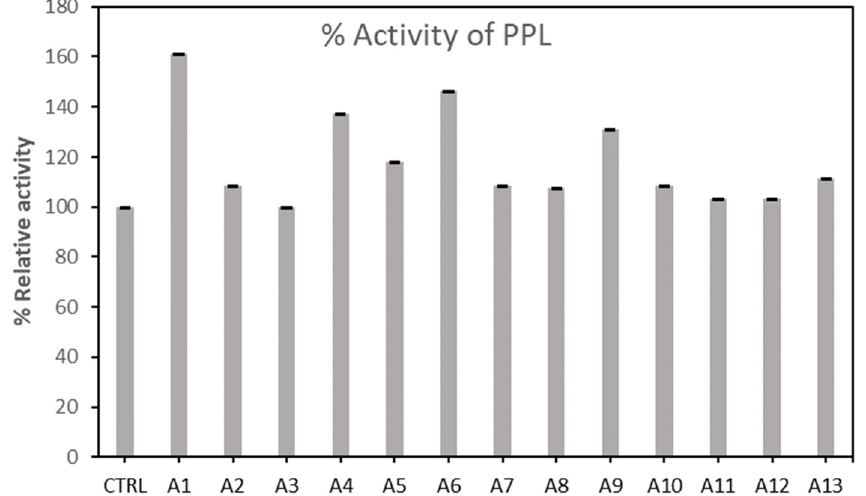
Figure 2. Relative activity of the Porcine enzyme (PPL) after the immobilization on activated carbon samples, from A1 to A13. Table 1. ANOVA Table for the relative activity of the Amano lipase (AML) and porcine enzyme (PPL) with activated carbon samples, from A1 to